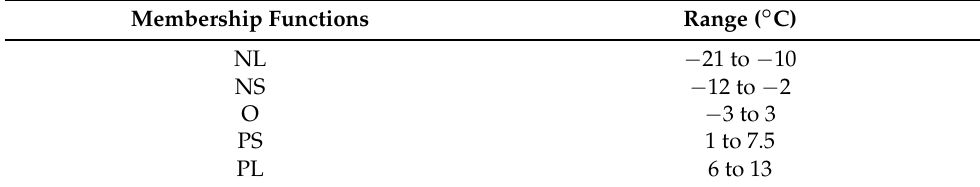
Table 4. Membership Functions for Deviation from the current Temperature.